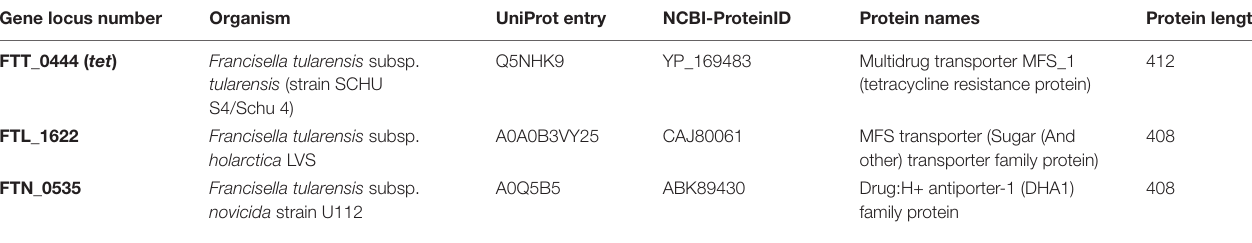
TABLE 5 | Identification of putative tetracycline resistance genes (Tet) in most strains of Francisella (selected data from Uniprot.org). Gene locus number